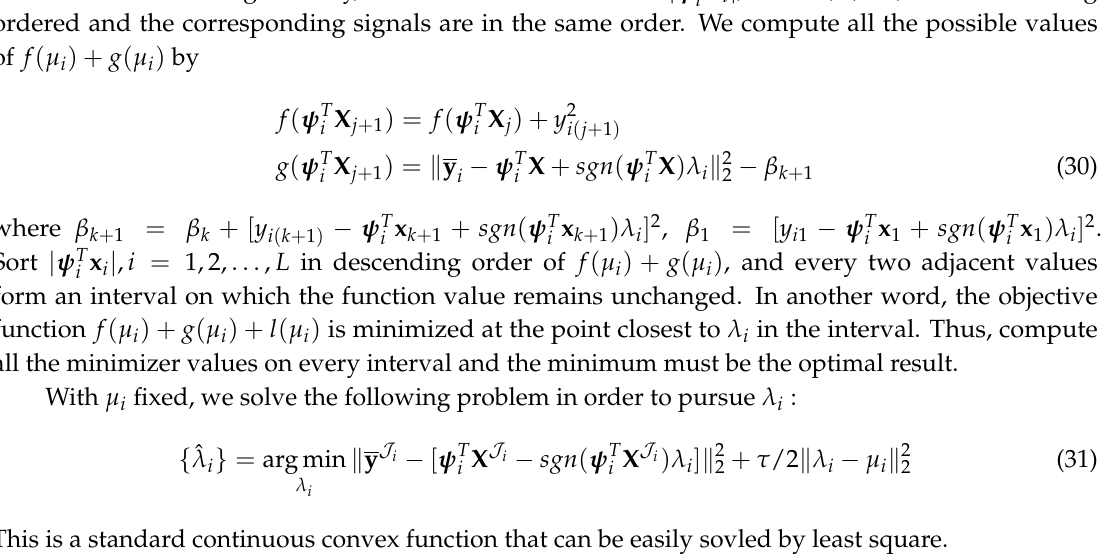
Algorithm 1 Sparse coding